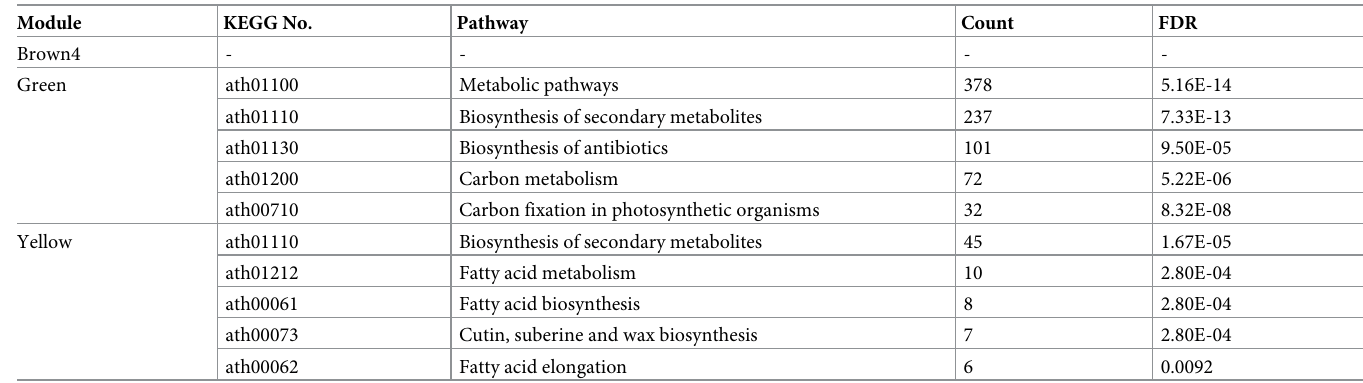
Table 3. KEGG pathway enrichment analysis of genes in the selected modules. Module KEGG